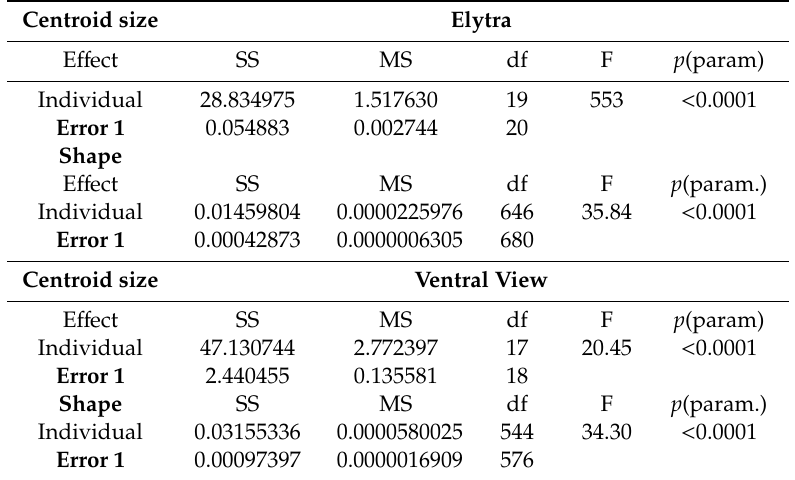
Table 1. Measurement error analysis by Procrustes ANOVA for both centroid size and body shape for elytra and ventral view in a subsample of the analyzed ground beetles.